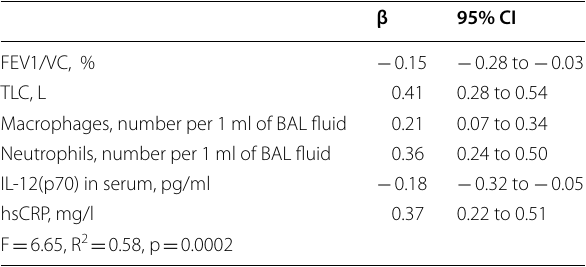
Table 4 Independent determinants of circulating H3cit in